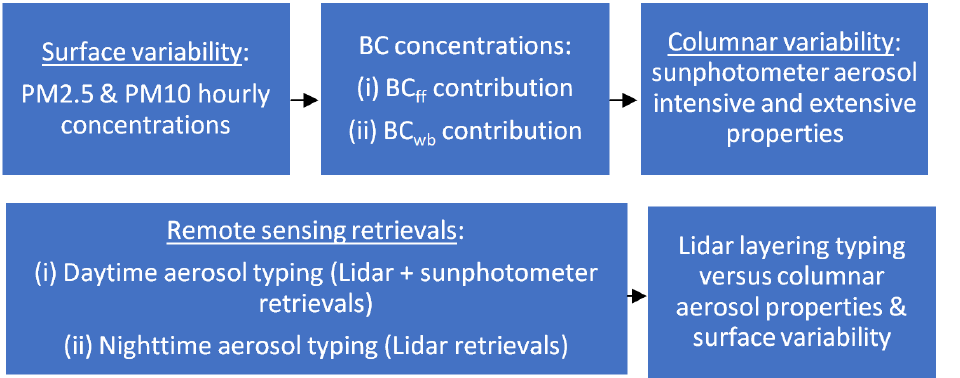
Figure 1. Schematic flowchart showing the methodology and the dataset used in the study.